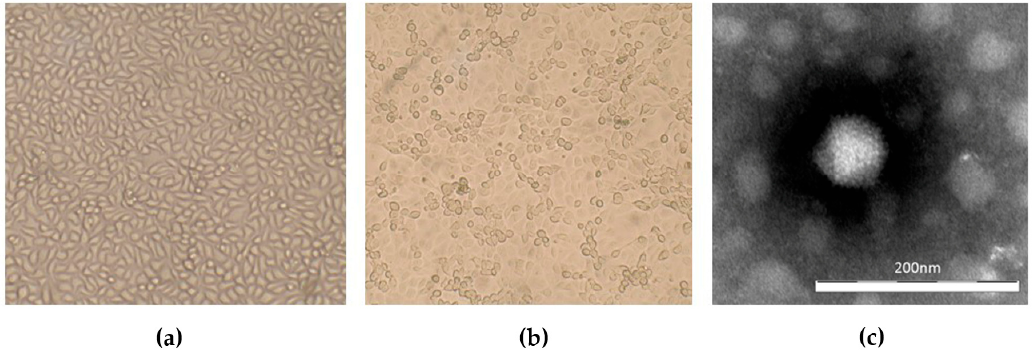
Figure 1. Detection of adenovirus isolate ITA/2018/251170-16 with MARC-145 cells. ( a ) Control cells, 10x magnification; ( b ) Infected cells showing CPE, 10× magnification; ( c ) negative staining (NaPT 2%) electron microscopy of ITA/2018/251170-16 virion. Bar represents 200 nm.